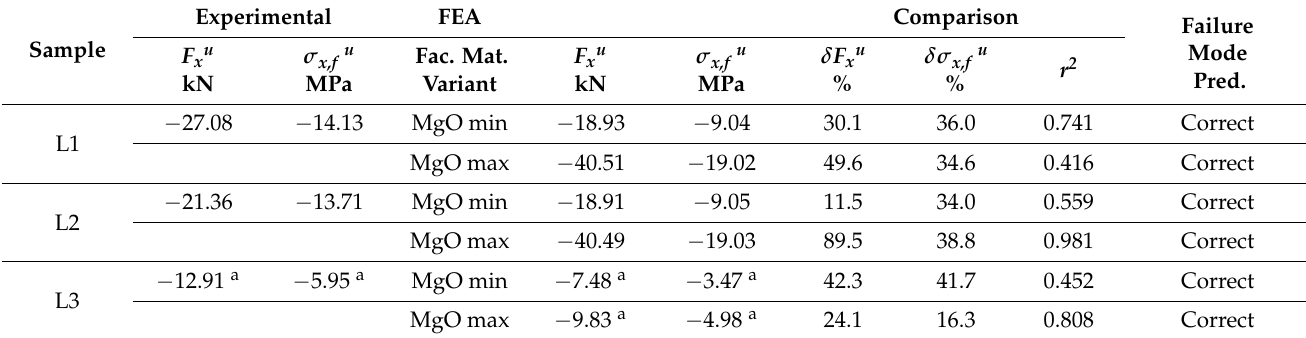
Table 3. Summary of small-scale FEA result similarity to experimental data.